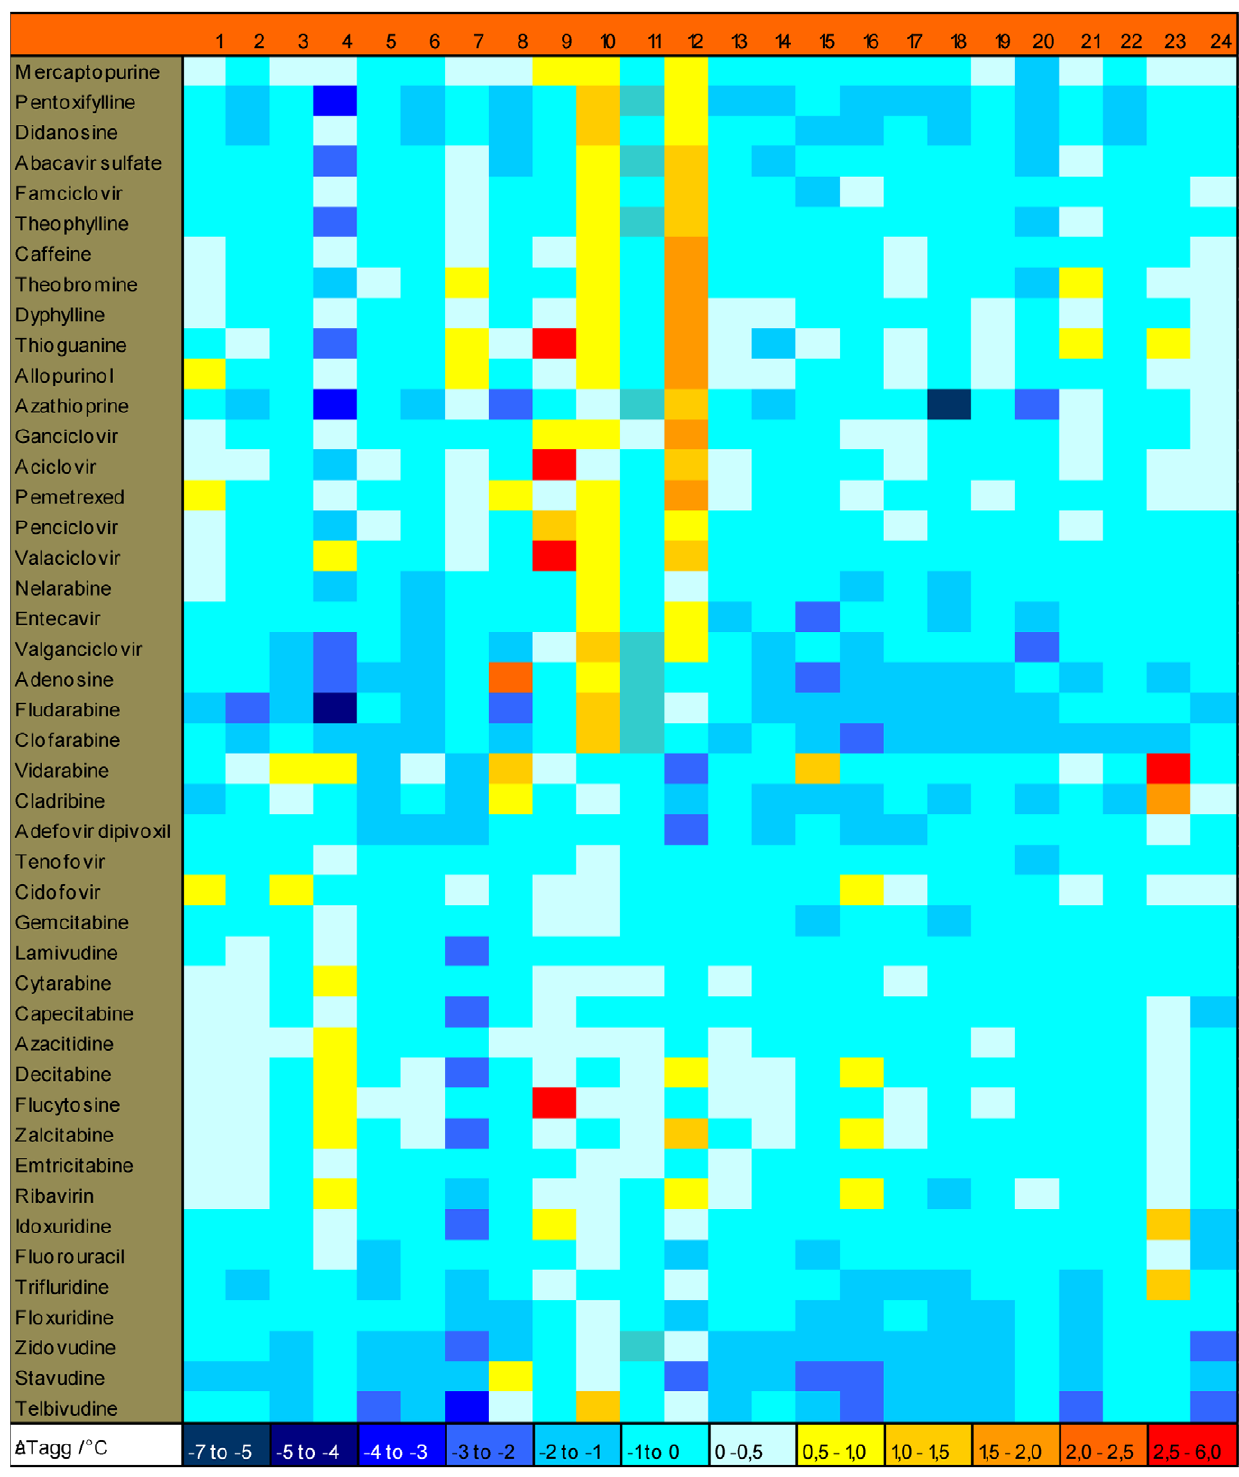
Figure 1. The D T agg values for the 23 enzymes screened against NAL. The enzymes are numbered: 1 ADSS2, 2 ADSL, 3 BPNT1, 4 CMPK2, 5 CTPS2, 6 DCTD, 7 DPYS, 8 GART, 9 GDA, 10 GMPR2, 11 GMPS, 12 ITPA, 13 NT5C2, 14 NT5C3, 15 NUDT16, 16 PAICS, 17 PRTFDC1, 18 RRM1, 19 UCK1, 20 UMPS (1), 21 UMPS (2), 22 UPB1, 23 UPP1, 24 UPP2. D T agg represents the difference between T agg of a protein in the presence and absence of a compound. The D T agg values are given as color codes based on D T agg calculated from two values within the same screen. The maximum average mean deviation for D T agg is 0.5 u C. However, in some cases, one of the values has been disregarded due to inappropriate curve fitting parameters. In total of 1080 measurements 44 have either one value missing (8) or an average mean deviation greater than 0.5 u C (36).